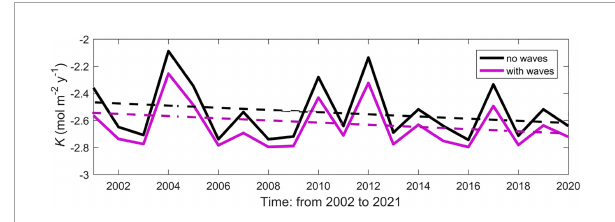
FIGURE 5 Temporal evolution of gas transfer velocity with waves (solid black) and no waves (solid